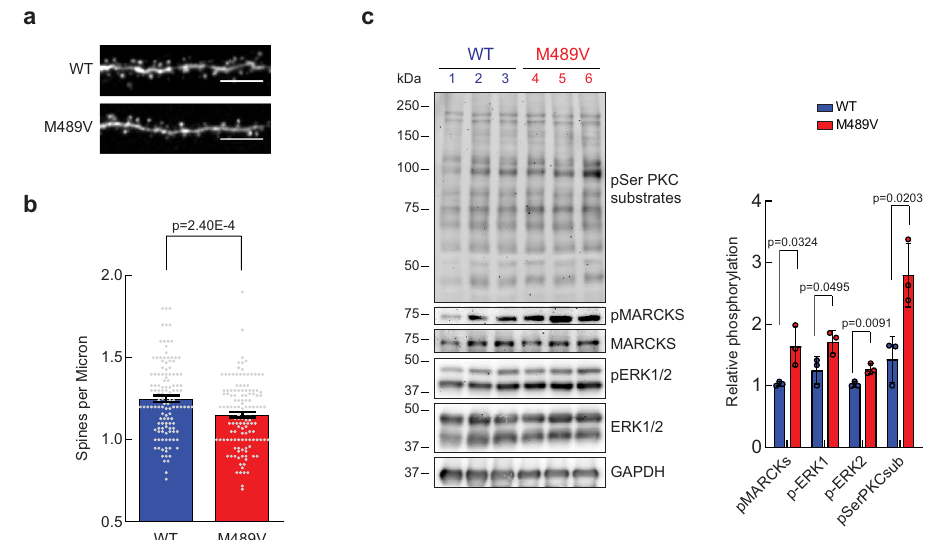
Fig. 2 | The AD-associated PKC α M489V mutation reduces spine density and increasesPKCsubstratephosphorylationinthehippocampus.a Representative immuno fl uorescence image of dendritic segments from hippocampal neurons injectedwith AlexaFluor® 594Hydrazide to follow neuronalprojections (dendritic segment=20 µ minlength, scalebar5 µ m). n =129dendriticsegmentsfrom6mice of each genotype were analyzed. b Average number of spines per micron in neu- rons isolated from 4 – 5-month-old WT or littermates M489V PKC α homozygous male mice ( n =6 mice of each genotype). Spines were counted in separate spine segments (10 – 25 µ m in length). Data show a spine density reduction of ~10%, from 1.25±0.02 spines/ µ m to1.15±0.02spines/ µ m in the M489V mice. n =129dendritic segments (over 1500 spines) were analyzed. Error bars show standard error of the mean. ( p =2.40E-4 using unpaired two-tailed Student ’ s t test). c Left. Immunoblots